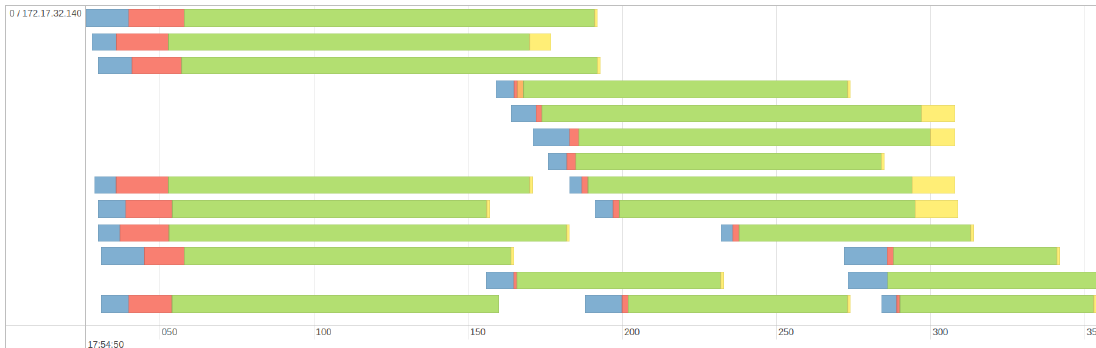
Figure 10. The workload after the repartitioning.